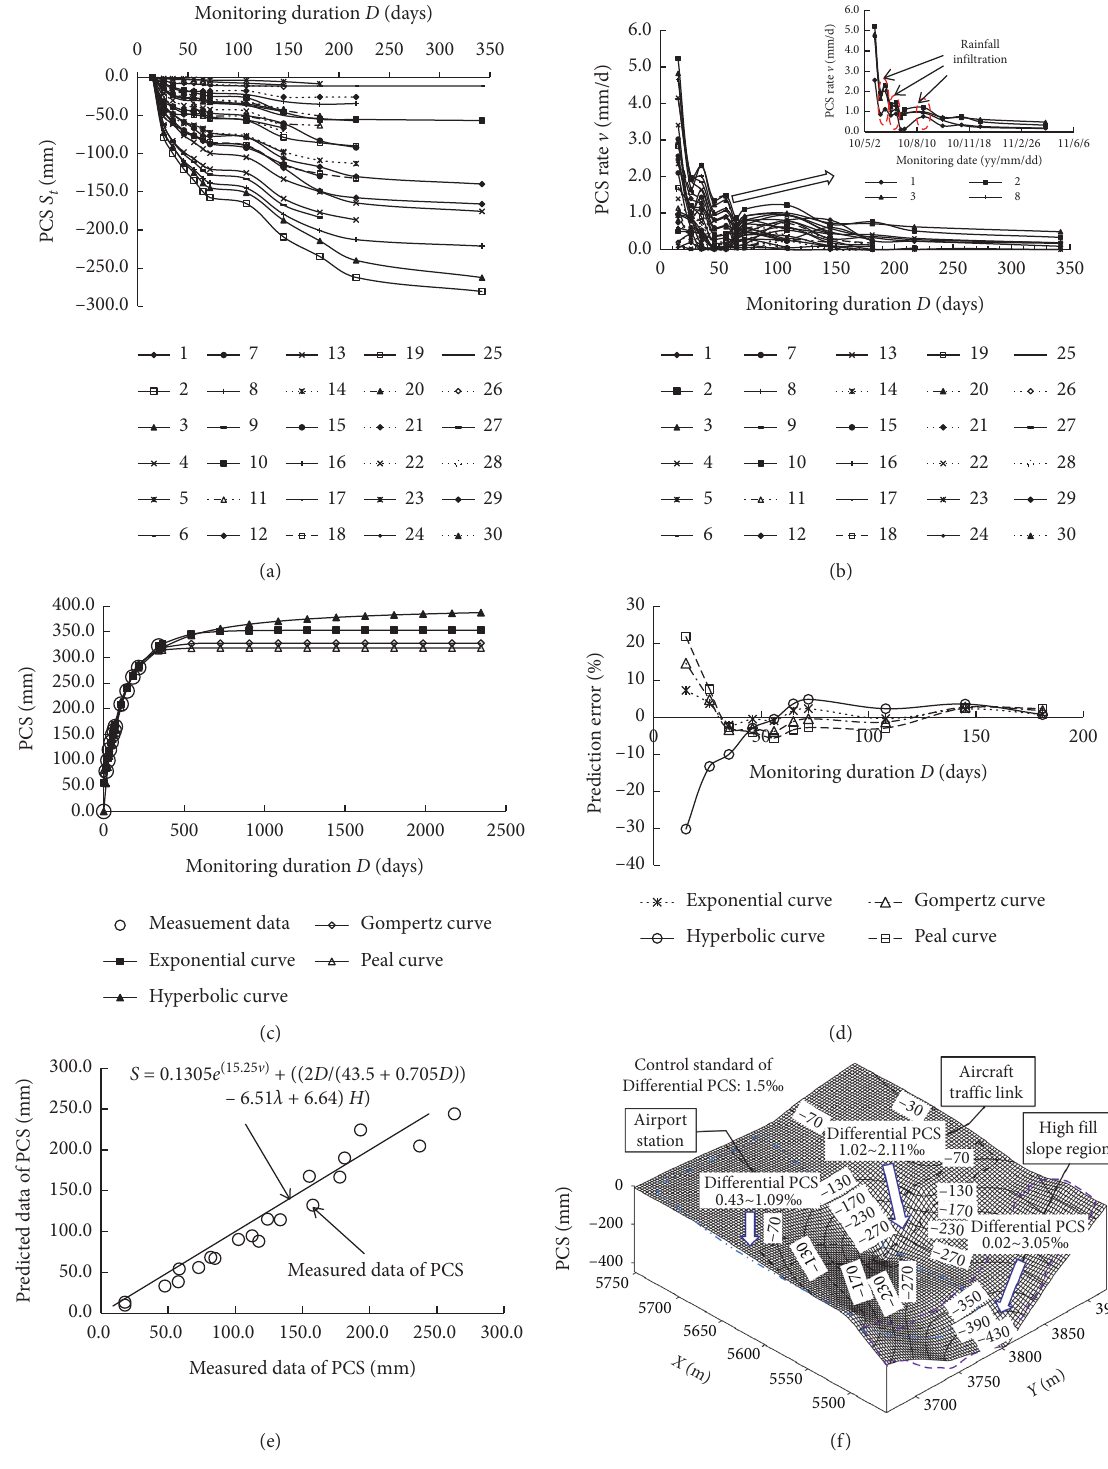
Figure 18: Crest PCS and differential PCS curves of the HFE. (a) PCS over monitoring duration. (b) PCS rate over monitoring duration. (c) Prediction of PCS. (d) Prediction error. (e) Comparison between prediction results and measured data. (f) Prediction PCS with the empirical